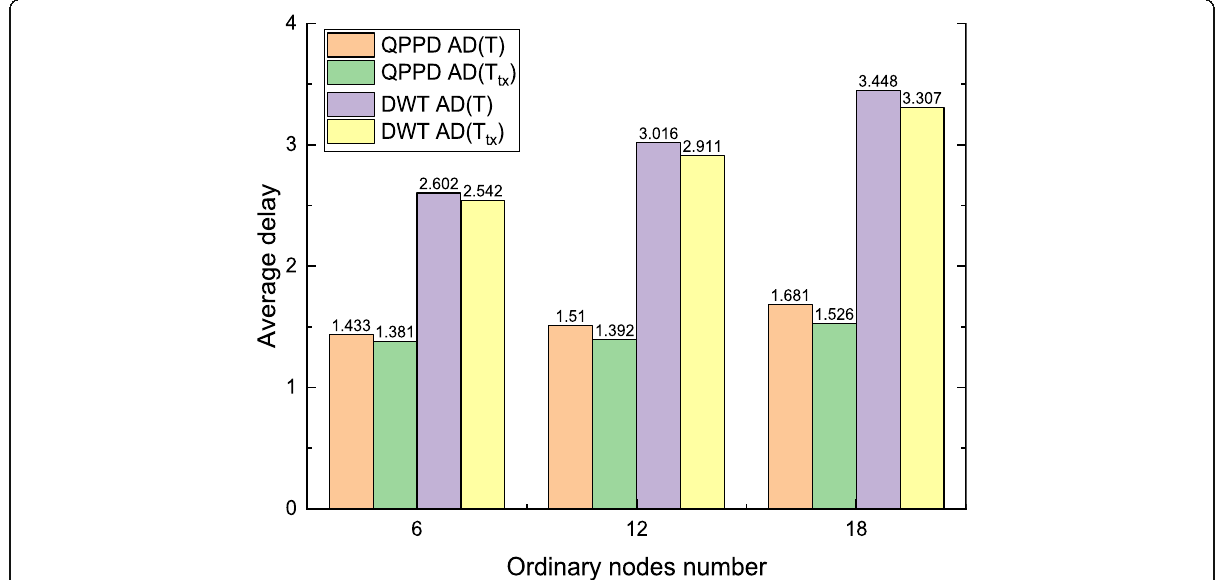
Fig. 14 The total number of periodic data changes increases from 0 to 6; the average delay of highest priority